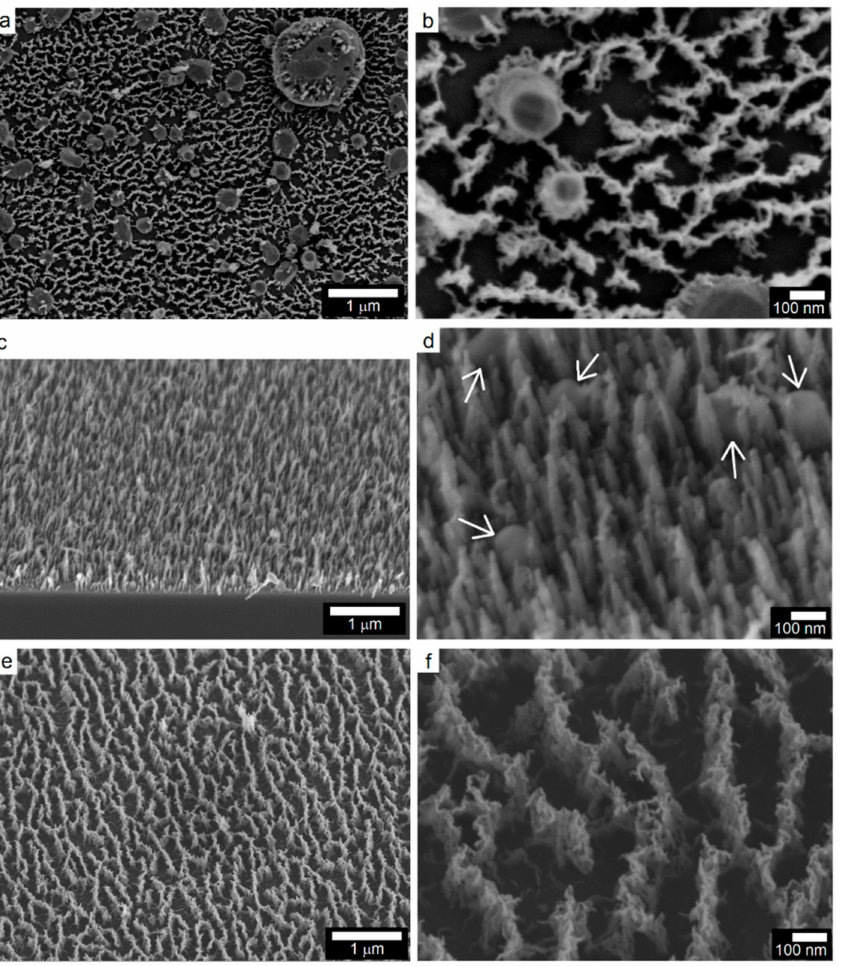
Figure 6. Low and high magnification SEM micrographs of the carbon nanostructures after PECVD growth over Si substrates supporting NP with different sizes: ( a , b ) Sample S 4 , ( c , d ) Sample S 5 , and ( e , f ) Sample S 7